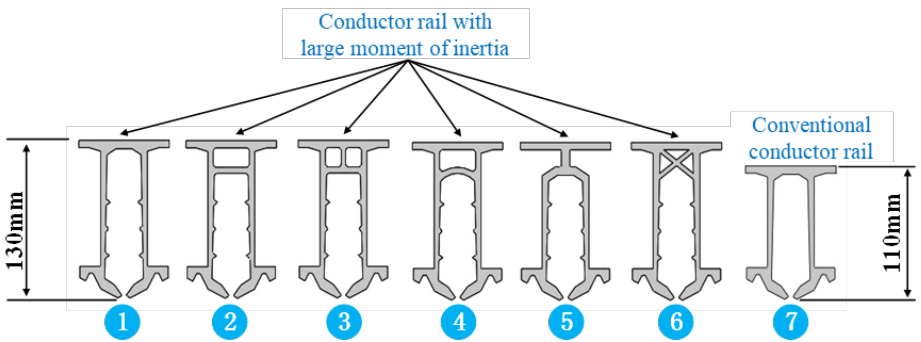
Figure 5. Six new types of conductor rail with large moment of inertia denoted as No. 1 – 6, and the conventional one denoted as No. 7.